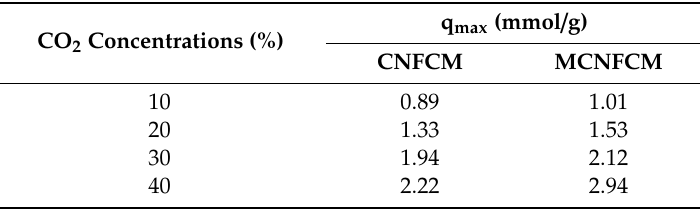
Table 9. CO 2 adsorption over di ff erent initial concentrations.